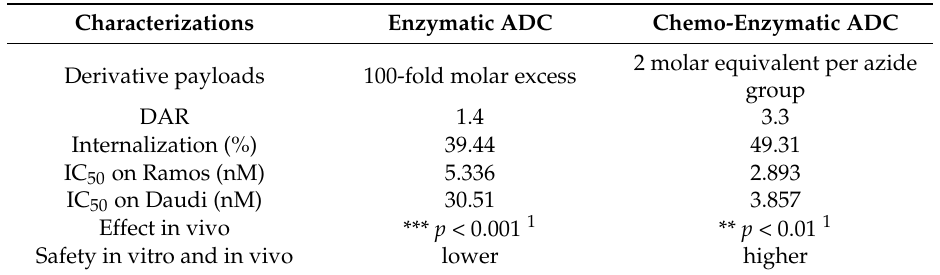
Table 1. The comparison of the different synthesis methods.